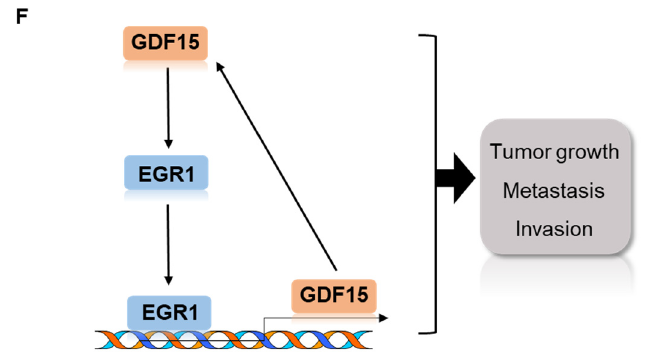
Figure 6. GDF15 can synergistically affect tumor growth of HNC with EGR1 in vivo. Luciferase-expressing FADU (Luc- FADU) HNC cells were injected subcutaneously into BALB/c-nude mice and treated with siGDF15, siEGR1 and cotreated with siGDF15 and siEGR1 or siNC every other day for 2 weeks. ( A ) Final tumor images of cancer cells tracked with the in vivo imaging system following the injection of mice with Luc-FADU cells. ( B ) Tumor growth curve in Luc-FADU-bearing mice that were injected with siGDF15, siEGR1, and cotreated with siGDF15 and siEGR1 or siNC. ( C ) Images of tumors at the experimental endpoint. The tumors were weighed at the time of sacrifice. ( D ) Western blots from xenograft tumor tissues. Changes in the protein expression of GDF15, EGR1, p -ERK, ERK, p -AKT and AKT in xenograft tissues of the four treatment groups. ( E ) Representative images of HE and immunohistochemical staining of the negative control group, siGDF15 treatment group, siEGR1 treatment group and cotreatment group. Scale bar, 50 µ m. Results were analyzed using one-way ANOVA. Data were expressed as mean ± SD. Differences were considered significant at p < 0.05 (* p < 0.05, ** p < 0.01, *** p < 0.001). All experiments were repeated two times. ( F ) Schematic diagram of this study. GDF15 promotes cell proliferation and metastasis in HNC through EGR1. Secreted GDF15 can activate SMAD2/3, AKT, ERK, as well as the well-known downstream component of the ERK pathway (EGR1) to form an EGR1-GDF15-ERK-EGR1 positive feedback loop.